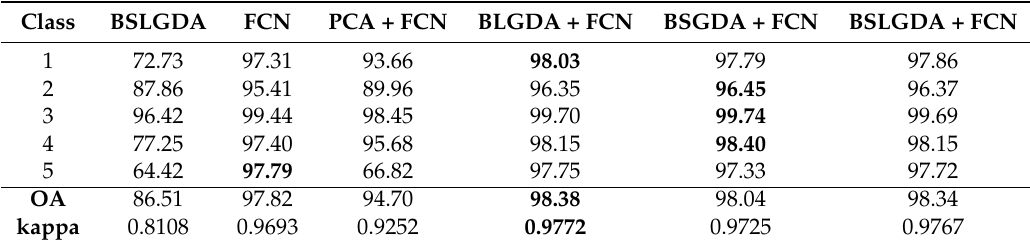
Table 2. SVM class-specific accuracy (%), OA and kappa coefficient of different methods for the San Francisco data set.